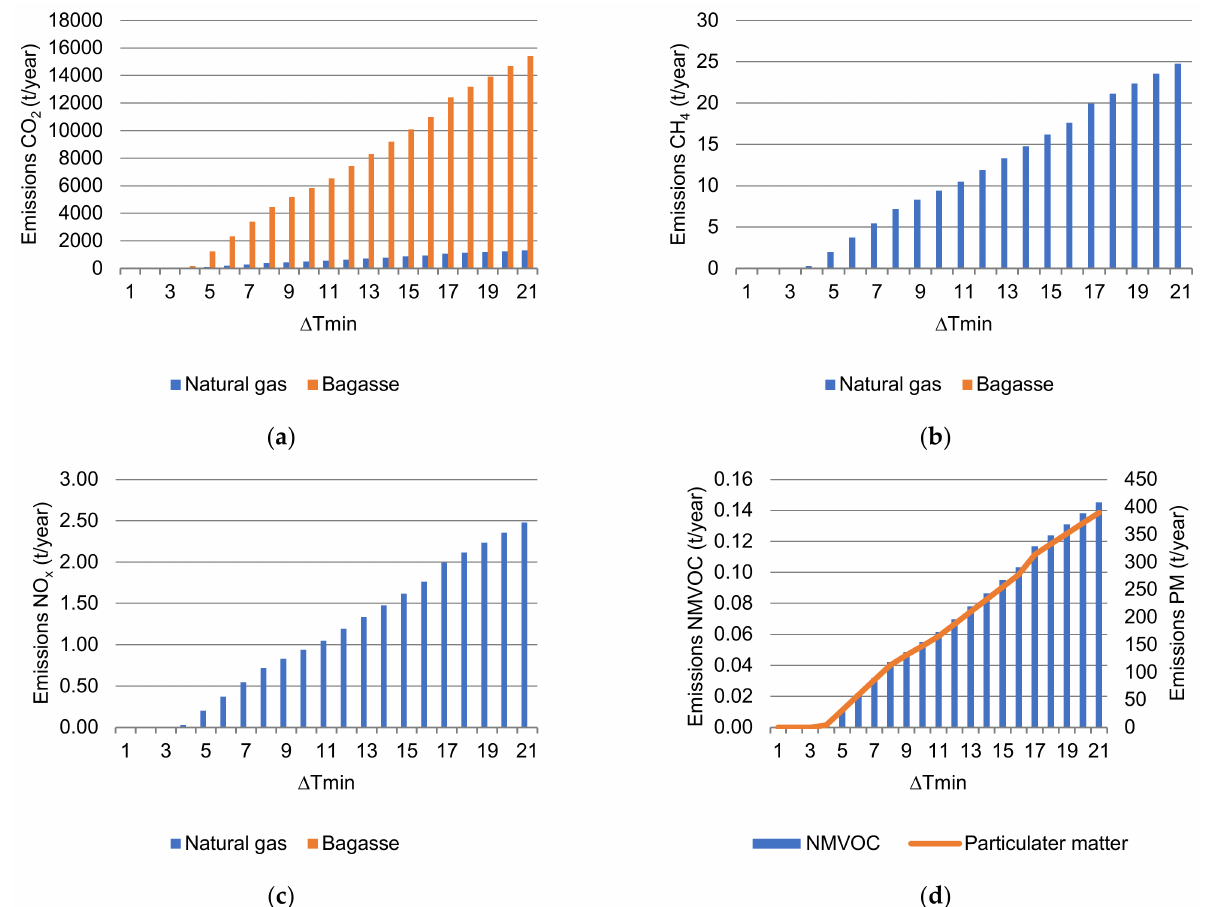
Figure 4. Variation of emissions for different ∆ T min . ( a ) Carbon dioxide, CO 2 , emissions; ( b ) Methane, CH 4 , emissions; ( c ) Nitrogen oxides, NO x , emissions; ( d ) Non-methane volatile organic compounds, NMVOC, and particulate matters emissions from bagasse.